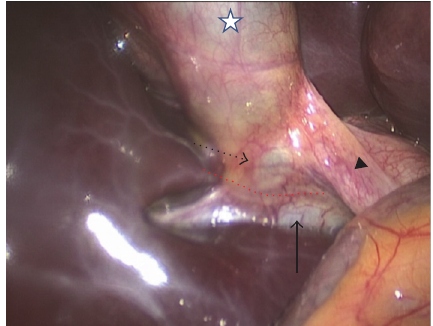
Figure 2: Laparoscopic overview of the Mirizzi syndrome (star: gallbladder, arrow head: cystic duct, dotted arrow: Hartmann’s pouch, arrow: common hepatic duct with stent, and dotted red line: the incision plan between Hartmann’s pouch of gallbladder and common hepatic